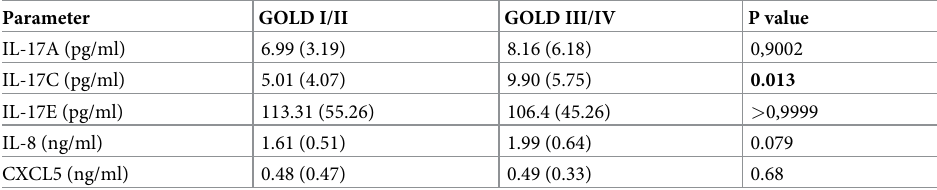
AECOPD, mice should be chronically exposed to CS and infected with viable NTHi. Table 2. Concentrations of cytokines.